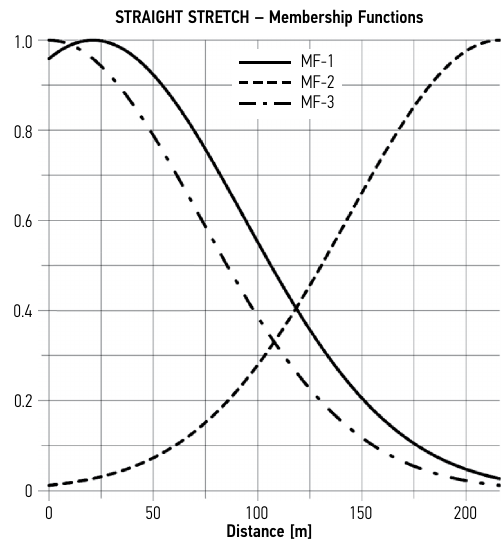
Fig. 5. Membership Functions (MF) of the input variable Straight Stretch ( St )